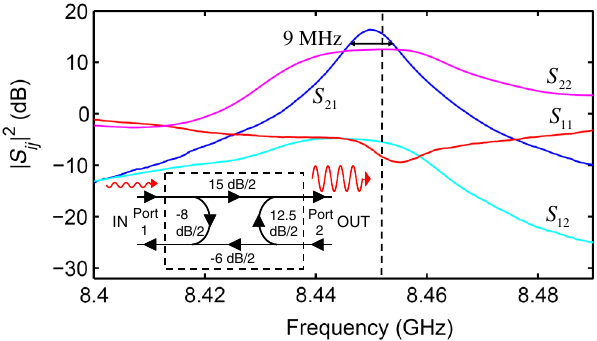
FIG. 4. A measurement of the scattering parameters of the device as a function of signal frequency taken for a fixed pump phase difference that maximizes directionality. The dynamical bandwidth of the device measured at the 3-dB points below the maximum S 21 gain is 9 MHz. In the bottom left part of the figure, we display a schematic sketch of the amplitude gain of the device at f 1 ¼ 8 : 453 GHz , which corresponds to the dashed vertical line. The pump amplitudes applied in this mea- surement are the same as in Fig. 2(a).